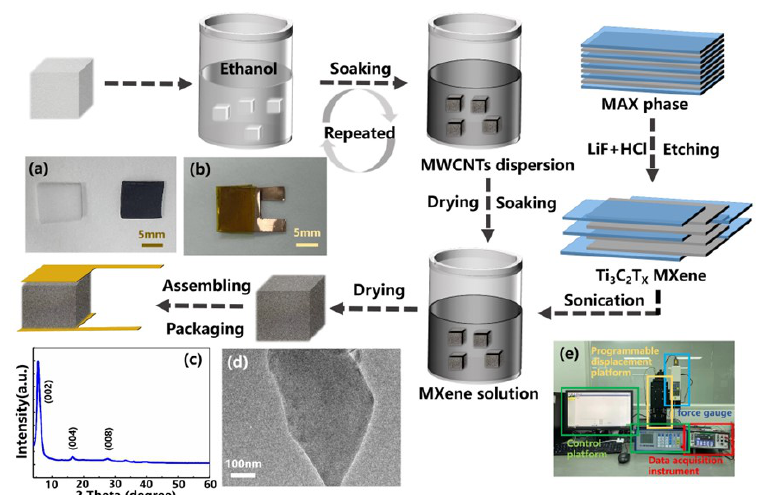
Figure 1. The manufacturing process of the MWCNTs/Ti 3 C 2 T x MXene @ melamine foam sensor. ( a ) Photos of the original melamine foam and the as-prepared MWCNTs/Ti 3 C 2 T x MXene @ melamine foam. ( b ) Photograph of the fabricated foam-shaped composite sensor taken by a digital camera. ( c ) X-ray diffraction (XRD) patterns of the MXene nanosheet. ( d ) TEM image of the MXene nanosheet. ( e ) The home-made mechanical testing system and the data acquisition